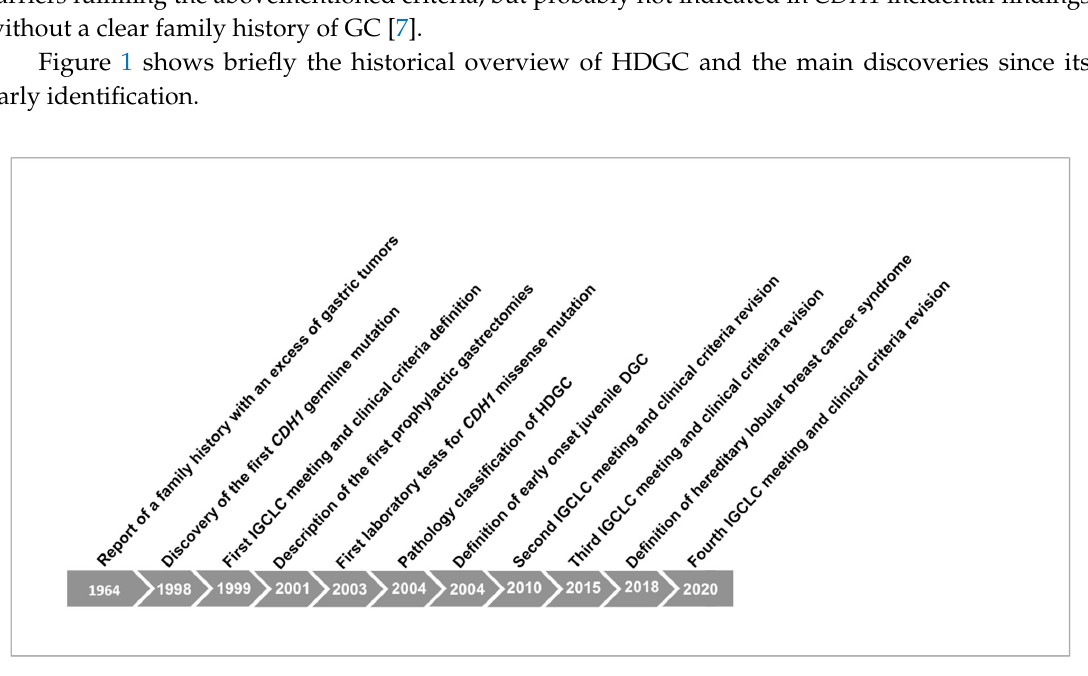
Figure 1. Historical overview of Herditary Diffuse Gastric Cancer (HDGC) syndrome and CDH1 germline mutation.